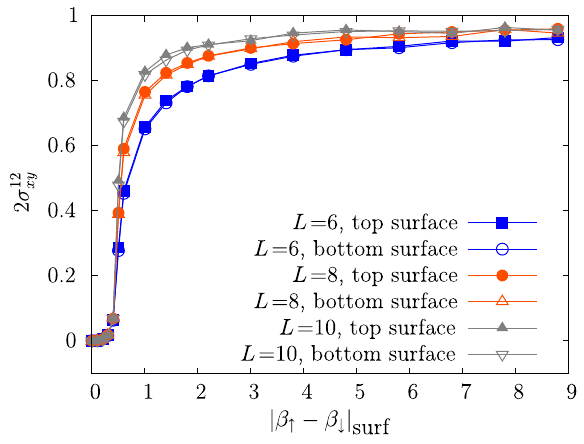
FIG. 13. Hall conductivity on the surface of the binding phase realized in the CP 1 version of the model, measured in units of e 2 =h (see text for details). On each surface, we find that the conductivity is quantized to 1, and this odd-integer value shows that we are on the surface of a bosonic TI. Data are taken ¼ 0 . 2 . We measure the same for K ¼ 0 . 4 , λ ¼ 8 , β ↓ ¼ β bulk conductivity on both the top and bottom surfaces of the topological